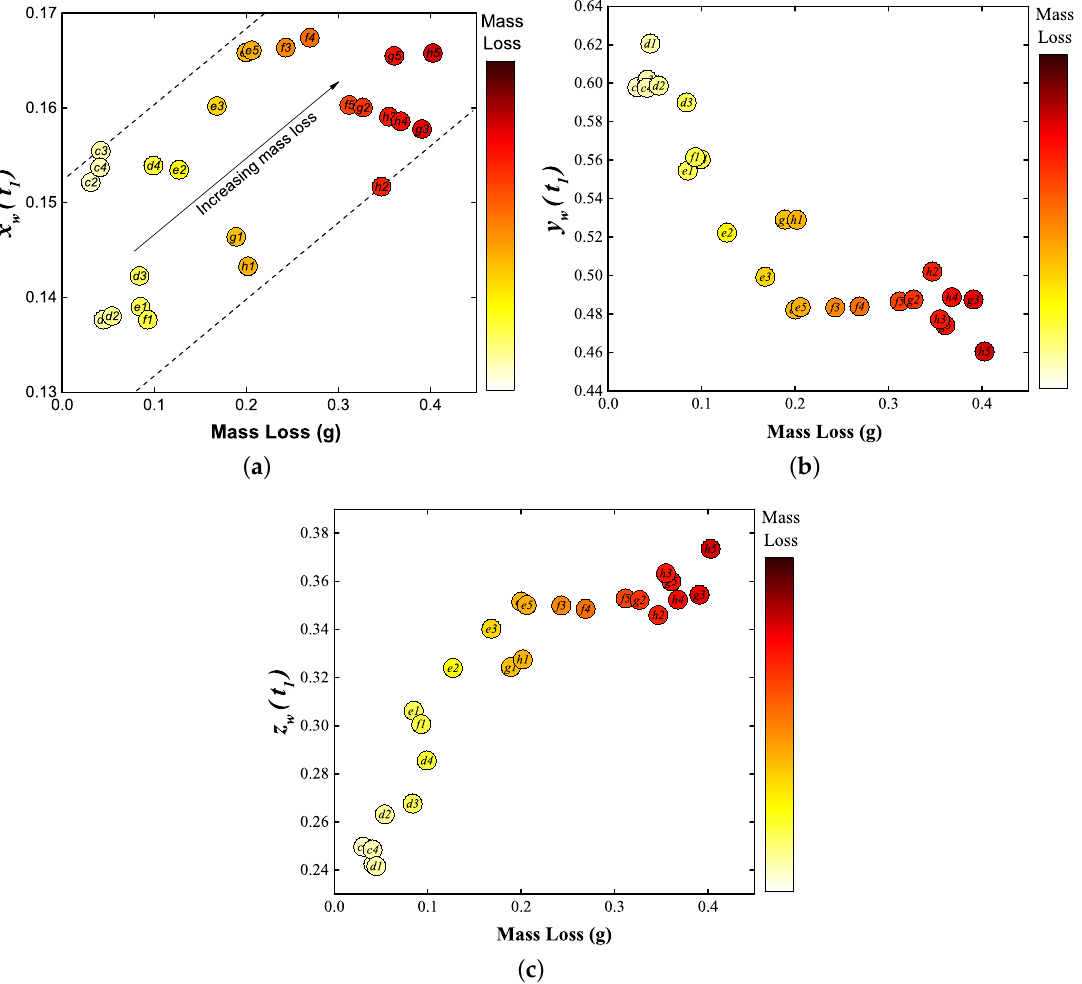
Figure 9. Primary chromatic parameters as functions of mass loss. ( a ) x w ( t 1 ); ( b ) y w ( t 1 ); and ( c ) z w ( t 1